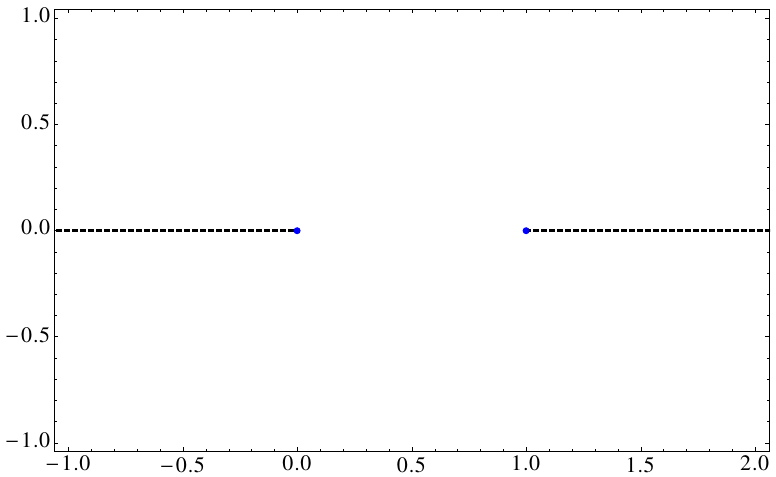
to 0 and another −∞ (1 , ). As an \ ∞